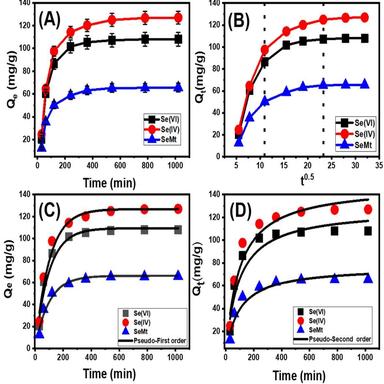
Effect of time on the adsorption of the different selenium species by CF/ZA composite (A), the Intra-Particle diffusion curves for the three selenium species (B), fitting of the results with Pseudo-First order kinetic model (C), and fitting of the results with Pseudo-Second order kinetic model (D).